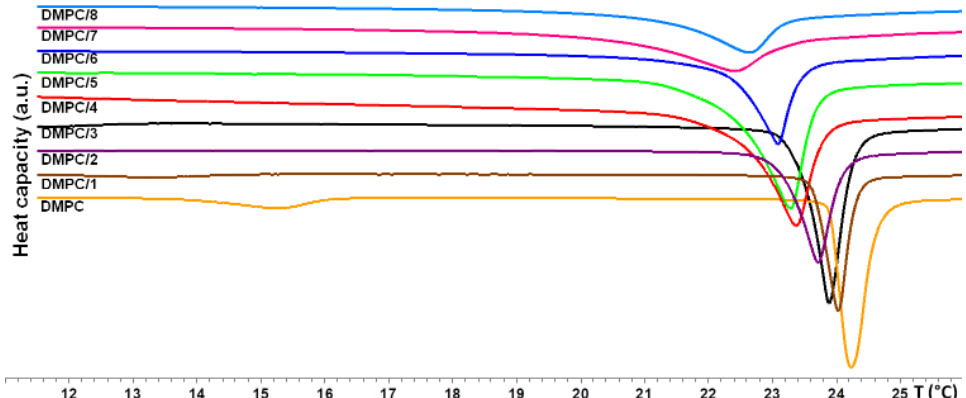
Figure 8. Thermograms of DMPC/quinolines MLV: DMPC, yellow line; DMPC/ 1 , brown line; DMPC/ 2 , purple line; DMPC/ 3 , black line; DMPC/ 4 , red line; DMPC/ 5 , green line; DMPC/ 6 , blue line; DMPC/ 7 , pink line; DMPC/ 8 , light blue line. Scan rate is 1 °C/min.